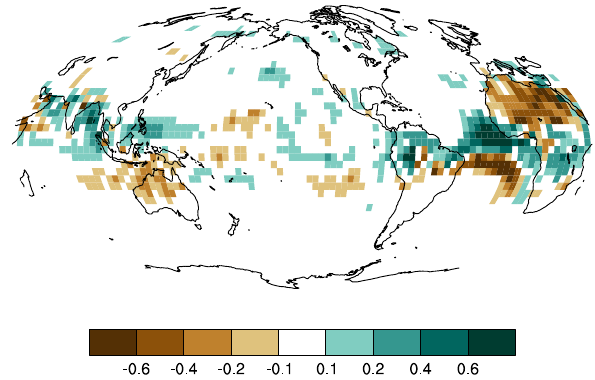
Figure B1. Mean precipitation difference (mmday − 1 ) between RETRO-S and RETRO. Note the different color scale when com- paring to Fig.